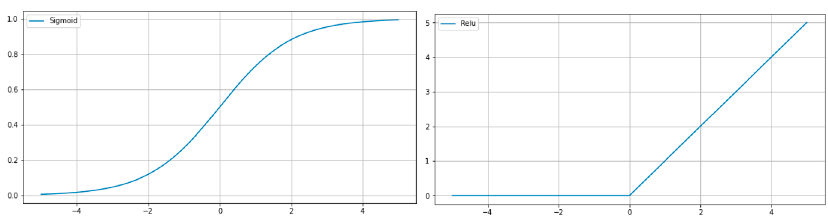
Figure 5. Inputs and MLP.